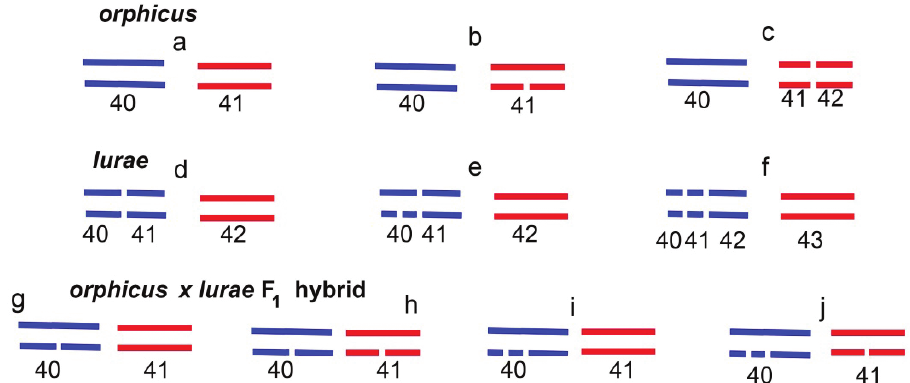
Figure 11. Scheme showing variation in number of chromosomes (lines) and visible elements (=bivalents+multivalents) in MI meiosis in P. orphicus , P. lurae and their putative F1 hybrids. a P. orphicus , homozygous for chromosomal fusion/fission, one pair of fused chromosomes, 41 visible elements b P. orphicus , heterozygous for chromosomal fusion/fission, 40 bivalents and one trivalent; 41 visible elements c P. orphicus , n=42 (homozygous for chromosomal fusion/fission, two pairs of unfused chromosomes; 42 visible elements d P. lurae , homozygous for chromosomal fusion/fission, one pair of fused chromosomes, 42 visible elements e P. lurae , heterozygous for chromosomal fusion/fission, 41 bivalents and one trivalent; 42 visible elements f P. lurae , homozygous for chromosomal fusion/fission, two pairs of unfused chromosomes; 43 visible elements g–j different variants of F1 hybrids. These variants include tri- and quadrivalents; however, the number of visible elements in MI remains